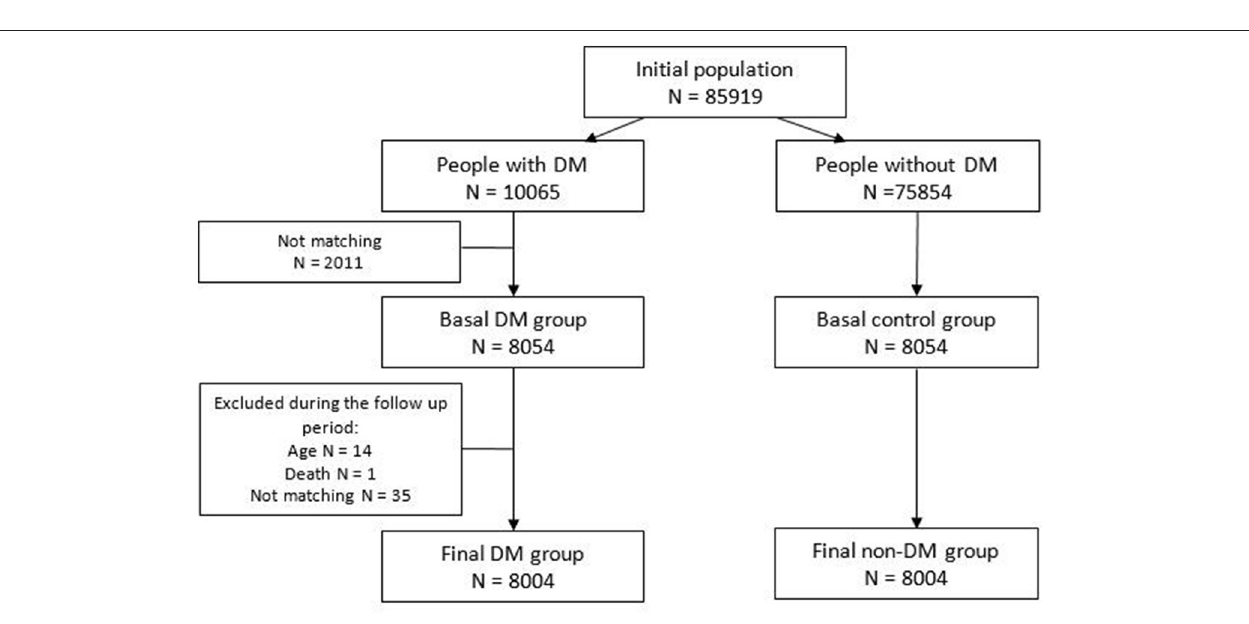
Frontiers in Public Health |